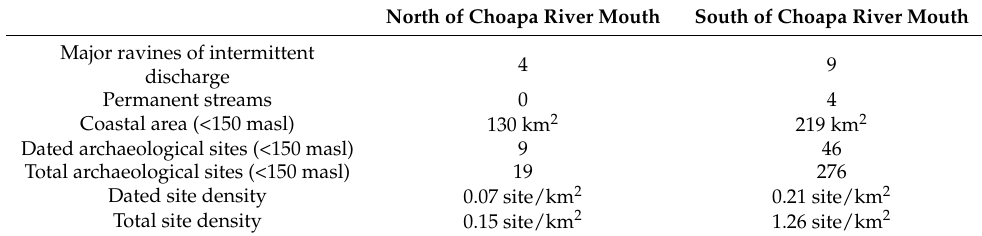
Table 2. Comparing geographic features and archaeological data on the coast between 31 ◦ and 32 ◦